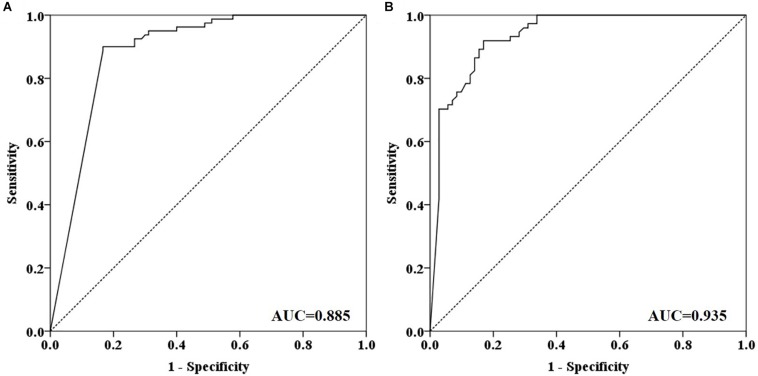
ROC curves for plasma and stool methylated SEPT9 tests in detecting CRC. (A) ROC curves for plasma methylated SEPT9 test. (B) ROC curves for stool methylated SEPT9 test.